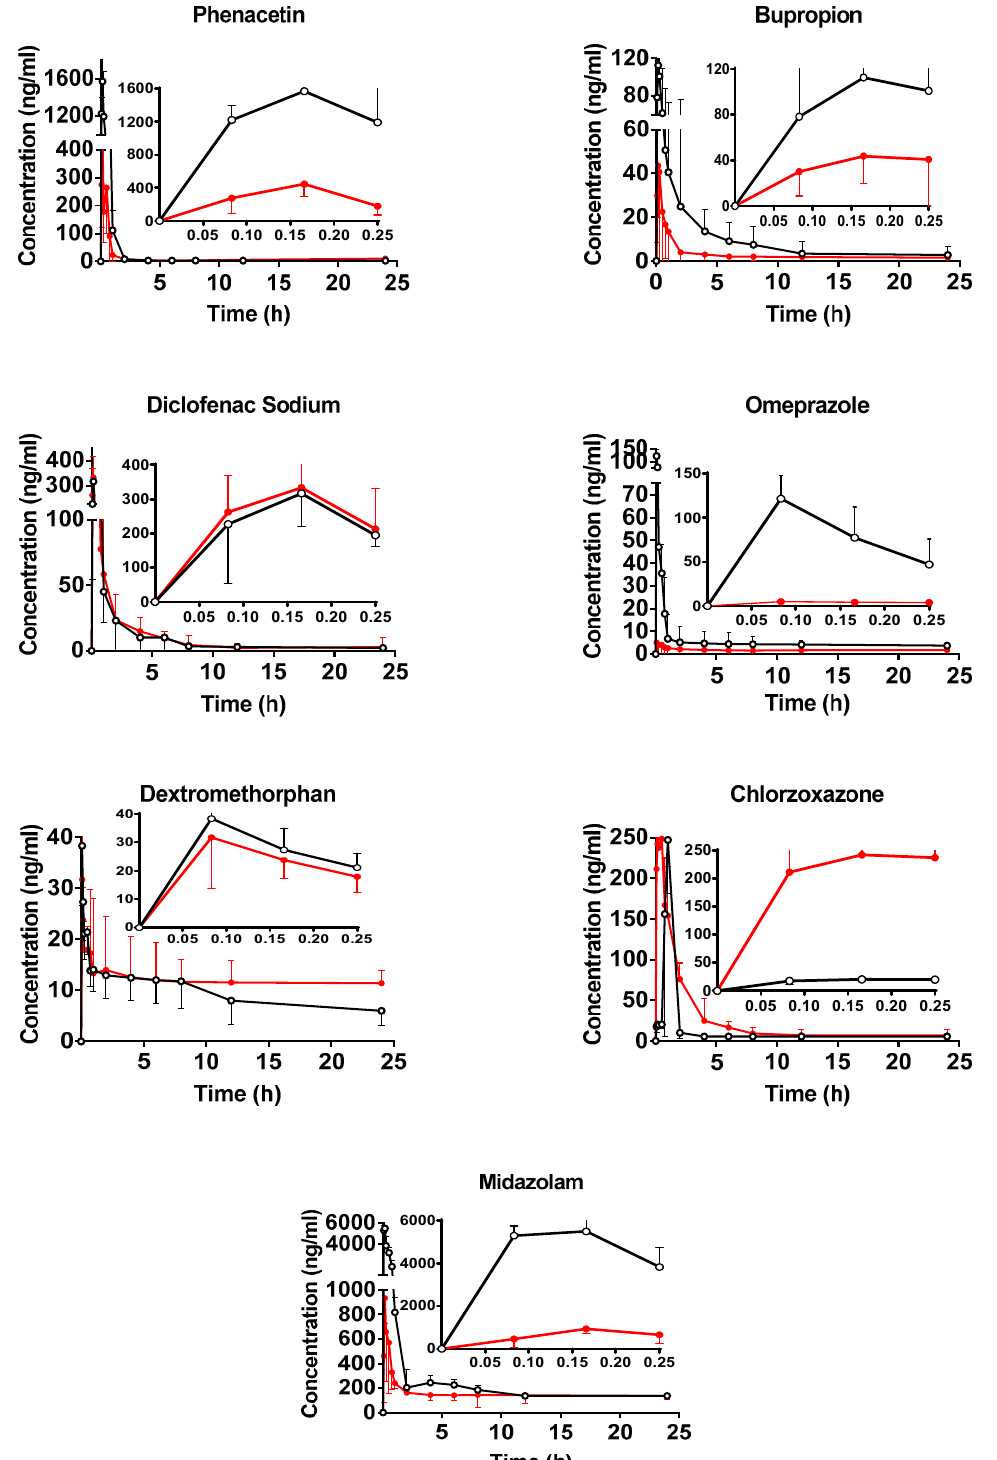
Figure 3. Mean plasma concentration–time curves of seven analytes in rats (mean ± SD , n = 6).